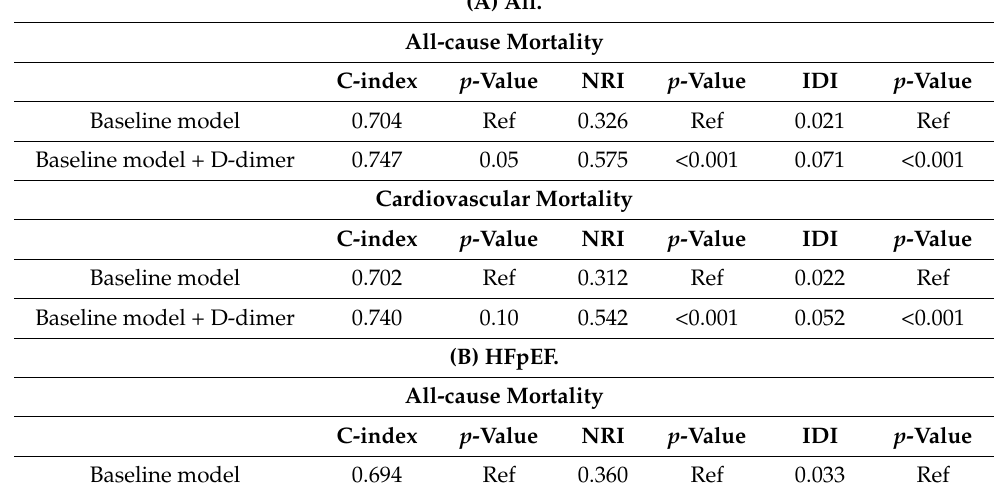
Table 6. Discrimination and reclassification of the combination of D-dimer with the GWTG-HF risk Score and NT-proBNP for all-cause and cardiovascular mortality in all populations (A), patients with HFpEF (B), and patients with HFrEF (C). (A)